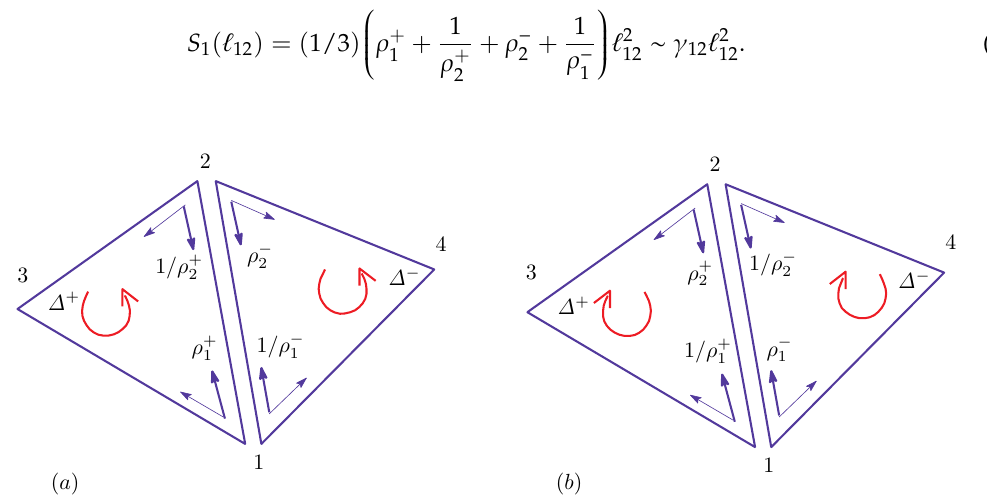
Figure A2. Local coordinate origins of the triangles ∆ + and ∆ − for S 1 ( (cid:96) 12 ) and the elements of γ 12 and γ 21 of the configurations of ( a ) the original and ( b ) the inside out (inside